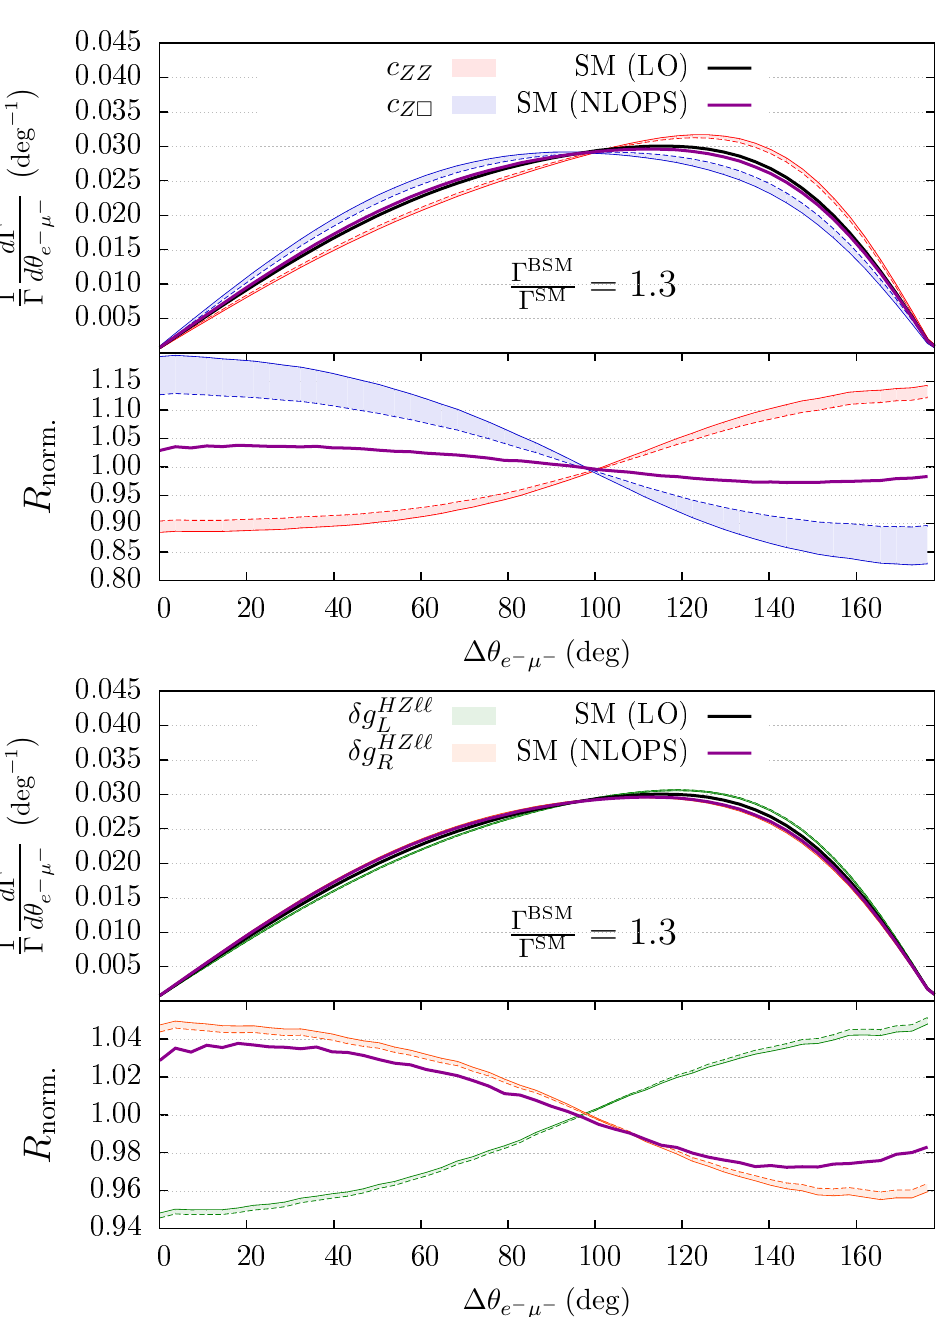
e (cid:0) (cid:22) (cid:0) at LO (black curve), at NLOPS EW and (cid:14)g HZ‘‘ R l